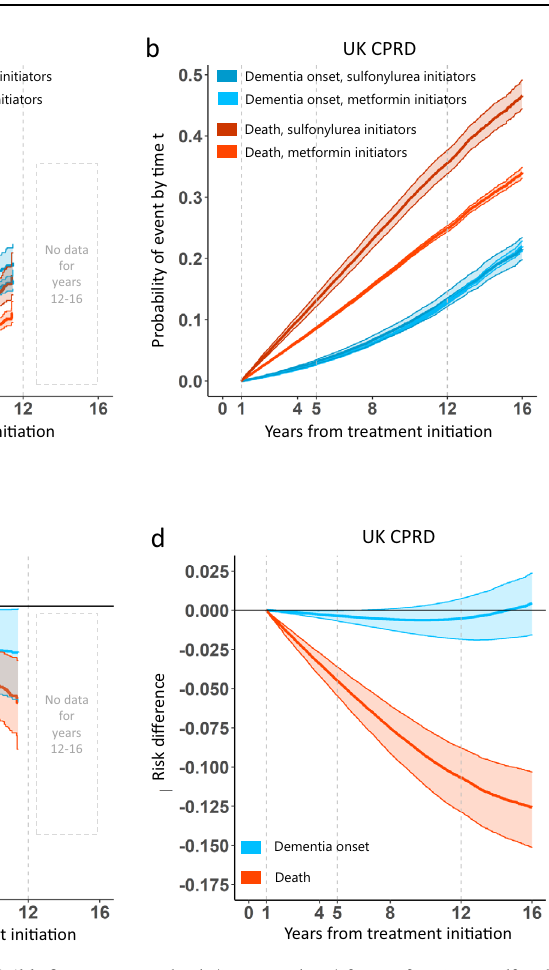
Fig. 4 | Risk differences in dementia onset over time are negligible for met- formininitiators,ascomparedtosulfonylureas. Cumulativeincidencefunctions (CIF) or risk curves, along with their 95% CIs (represented by shaded areas), based on pointwise 0.025- and 0.975-quantiles of sample bootstrap distributions, were estimatedusing the Cox model for the cause-speci fi c hazards, with only treatment as a covariate and baseline covariate distributions between treatment arms balancedbyIPTW. a , b CIFcurvesfordementiaonset(inbluehues)andcompeting